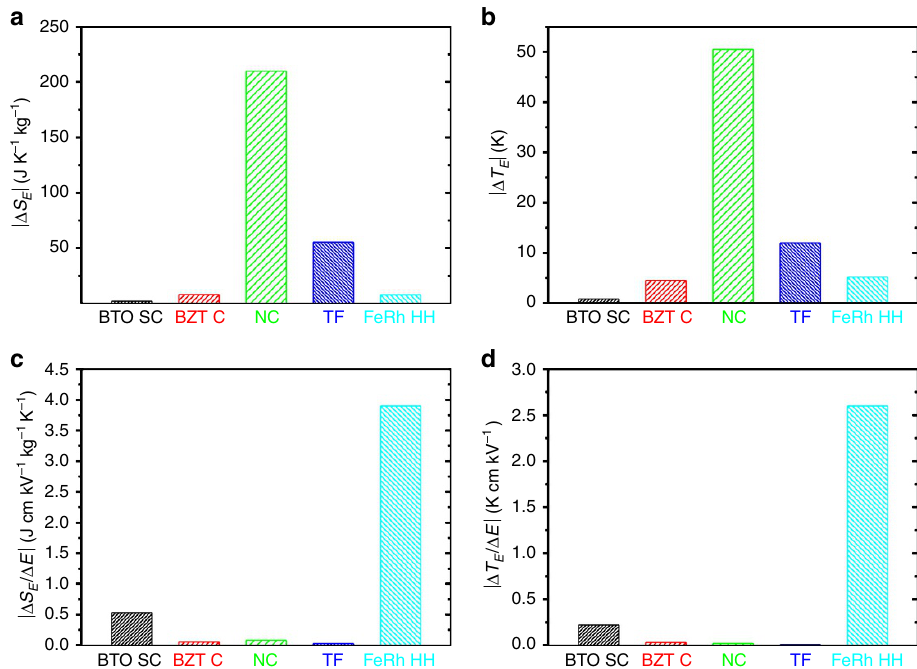
Figure 3 | Comparison of different electric field-induced caloric effects in selected materials. Comparison of caloric effect ( a ) | D S E | and ( b ) | D T E | and strength ( c ) | D S E / D E | and ( d ) | D T E / D E | between FeRh/BaTiO 3 hybrid heterostructure (HH) and typical giant electrocaloric materials in the literature: BaTiO 3 single crystal (SC) (ref. 29), BaZr 0.2 Ti 0.8 O 3 (BZT) ceramic (C) (ref. 30), P(VDF-TrFE-CFE)/Boron nitride nanosheets/Ba 0.67 Sr 0.33 TiO 3 nanocomposite (NC) (ref. 31) and P(VDF-TrFE) thin film (TF) (ref. 32),